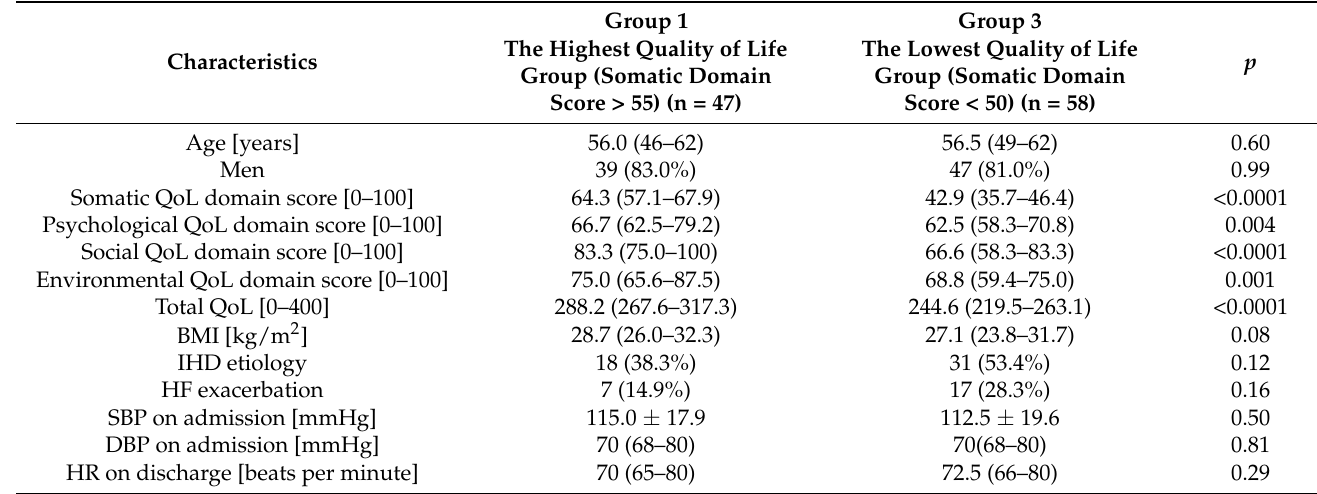
Table 2. Comparison of patients with the highest and the lowest score in the somatic domain of the World Health Organization’s Quality of Life Instrument–Short Version (WHOQoL-BREF)